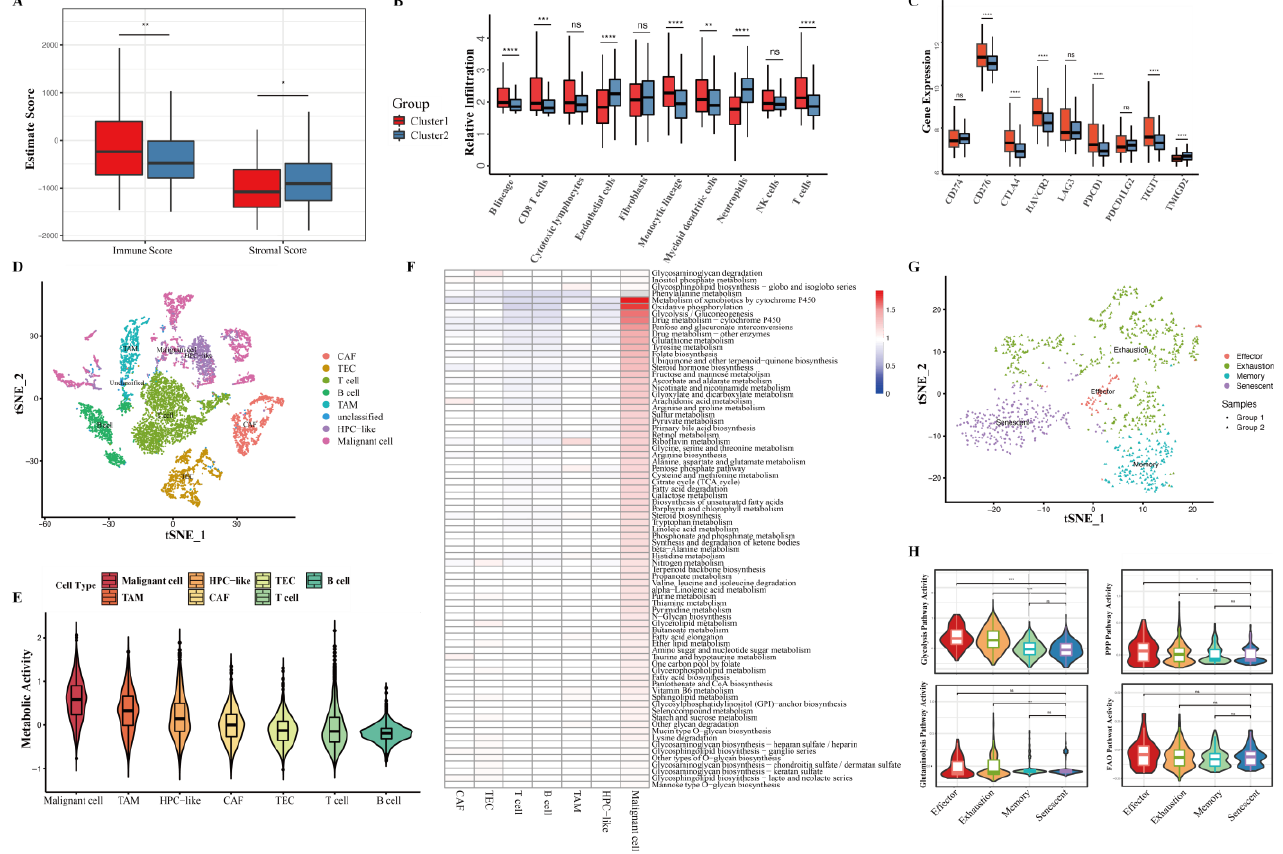
Figure 6. Distinct immune microenvironments between two liver cancer metabolic subtypes. ( A ) Immune and stomal scores calculated by the Estimate algorithm. ( B ) Relative abundance of immune and stromal cells. ( C ) Quantification of selected immune checkpoint genes in two clusters. ( D ) t-distributed stochastic neighbor embedding (t-SNE) plot of all cells from GEO: GSE125449. ( E ) Relative metabolic pathway activity levels among seven cell types from GEO: GSE125449. ( F ) Heatmap displaying KEGG metabolic pathway activity levels across seven cell types from GEO: GSE125449. ( G ) t-SNE plot of CD8+ T cells from GEO: GSE125449. ( H ) Violin plots depicting the four energy metabolic activity levels across different CD8+ T cell subtypes. ns, p value > 0.05; *, p value < 0.05; **, p value < 0.01; ***, p value < 0.001; ****, p value < 0.0001.